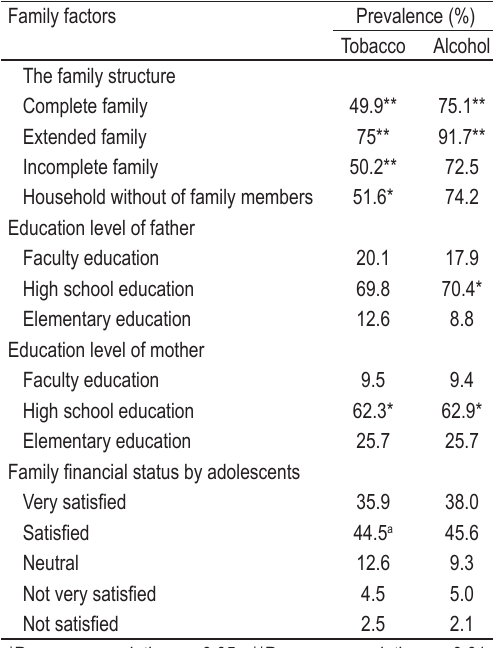
FIGURE 2. The adolescent’s opinion on the parent’s reactions toward substance TABLE 1. The prevalence of tobacco and alcohol adolescents use by gender